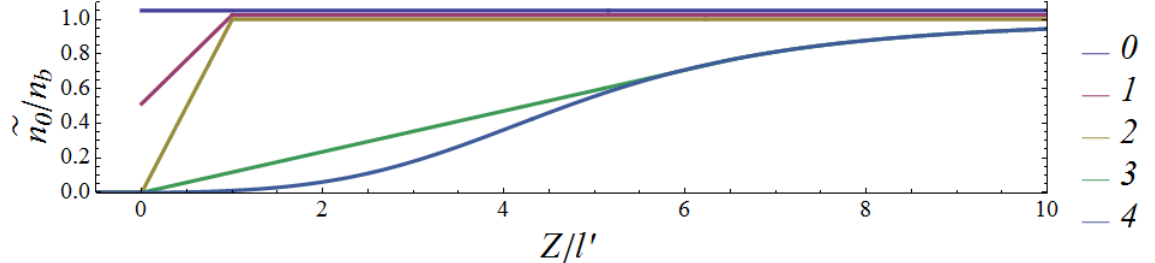
Figure 2. Plots of the ratios (cid:102) n 0 / n b for the following initial densities: (0) (cid:102) n 0 ( z ) = n b θ ( z ) . (1) 1 n b θ ( z )[ 1 + θ ( l (cid:48) − z ) z / l (cid:48) + θ ( z − l (cid:48) )] . (2) (cid:102) n 0 ( z ) = n b [ θ ( z ) θ ( l (cid:48) − z ) z / l (cid:48) + θ ( z − l (cid:48) )] . (3) (cid:102) n 0 ( z ) = (cid:102) n 0 ( z ) = 2 (cid:110) f ( ¯ z ) z n b θ ( z ) θ ( ¯ z − z ) + θ ( z − ¯ z ) f ¯ z 1 + f ( ¯ z ) grows as z for z ≤ ¯ z and coincides with the next one for z > ¯ z . (4) (cid:102) n 0 ( z ) = n b θ ( z ) f